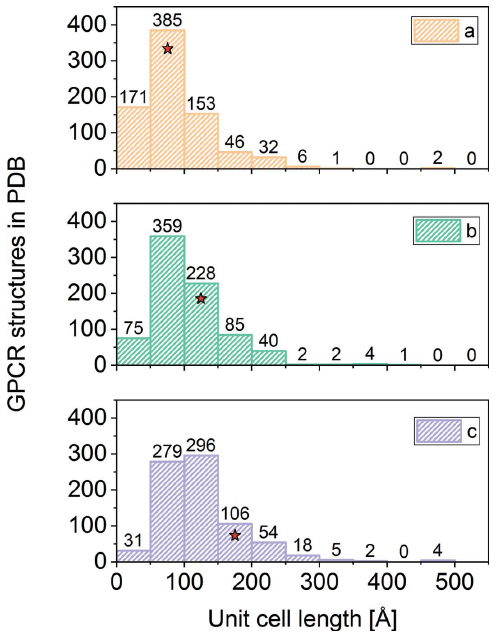
Figure 4 Histograms of the unit-cell lengths for all unique GPCR entries deposited in the PDB (Berman et al. , 2003). Numbers above the bars indicate the count in each bin. The unit-cell lengths of the 5-HT 2B receptor belong to one of the most frequently occurring GPCR unit-cell lengths in the PDB (bins marked with the star) and therefore serve as a representative candidate for the simulations.